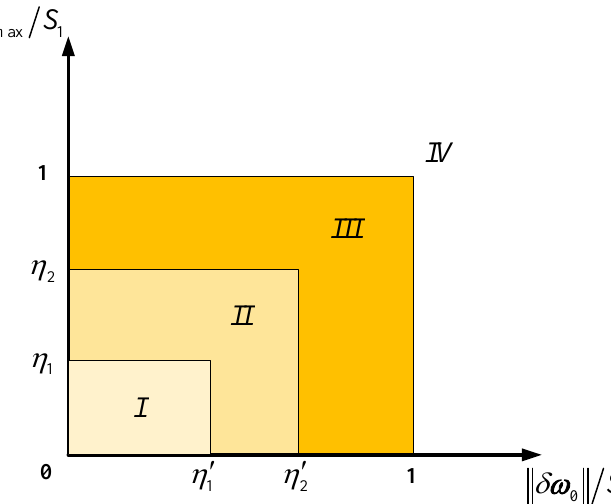
Figure 5. Two-dimensional risk assessment space.